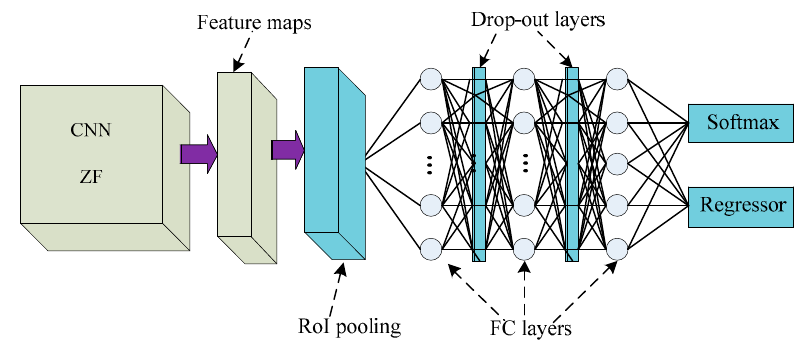
Figure 8. The structure of the improved Fast R-CNN.